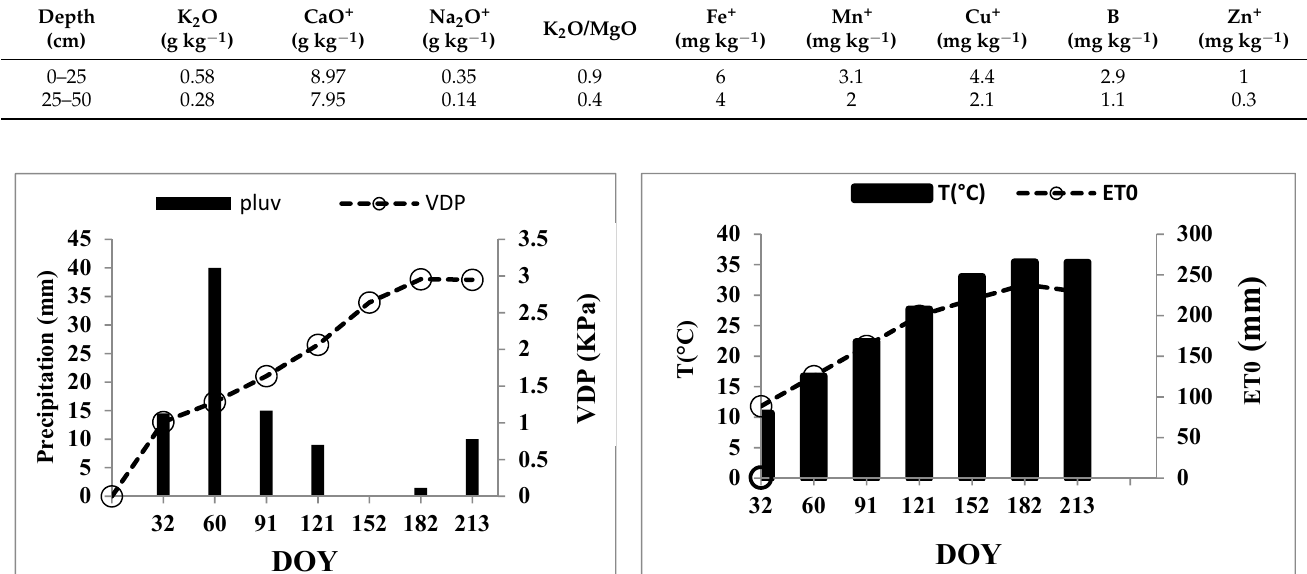
Figure 1. Precipitation (mm) and vapor pressure deficit (KPa) in terms of DOY. Average of daily mean air temperature (T) and crop reference evapotranspiration (ET 0 ) in terms of DOY, for the period 2011–2012. The meteorological station is located 1 km from the experimental orchard. Table 1. Soil chemical composition in the studied orchards.